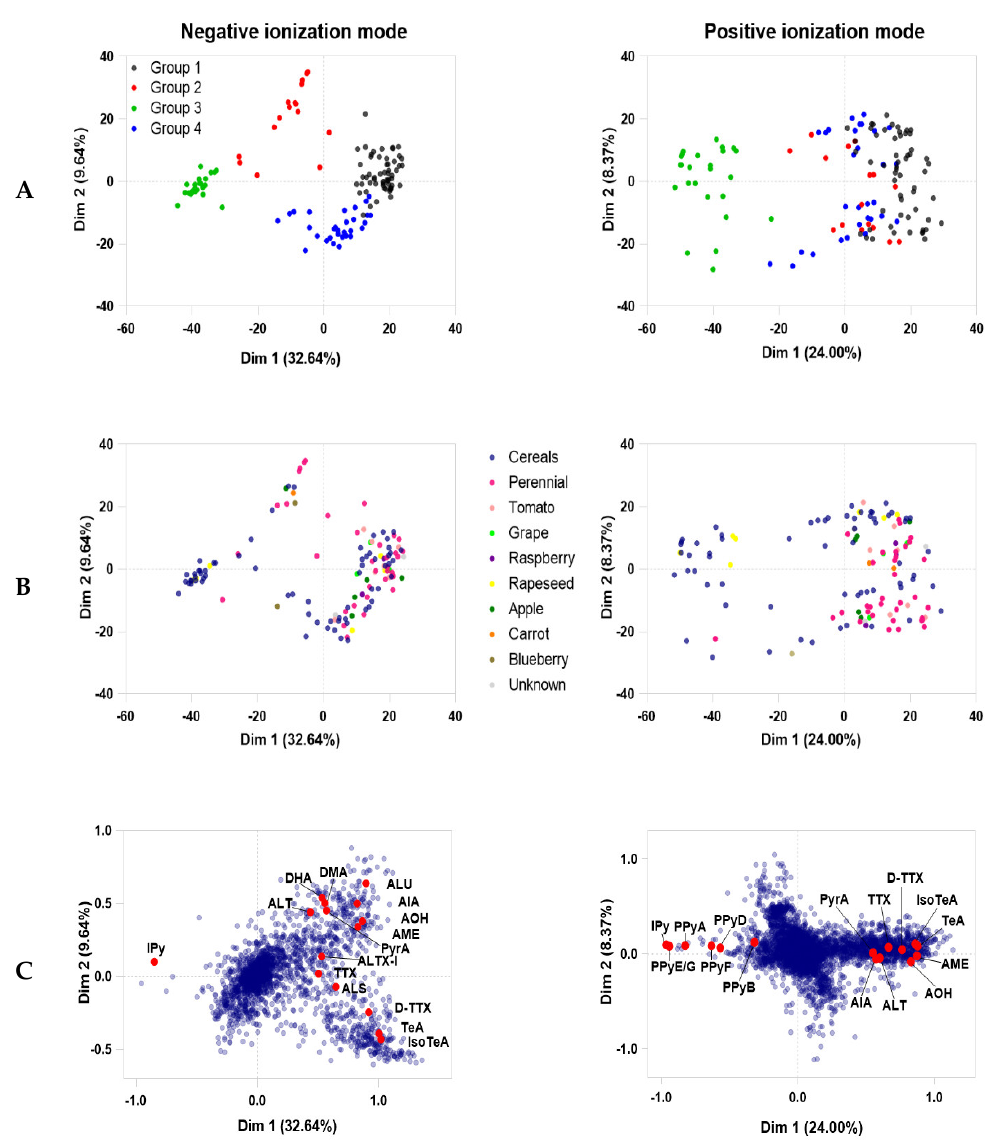
Figure 1. Principal component analysis (PCA) in both negative and positive ionization modes, where each point represents a single strain. ( A ) Strains in the PCA are coloured by k -means clustering group assignments from negative ionization mode. ( B ) PCA coloured by the substrate where strain was isolated. ( C ) Loadings plots indicating the positions of the main metabolites detected that influence the PCA separations.